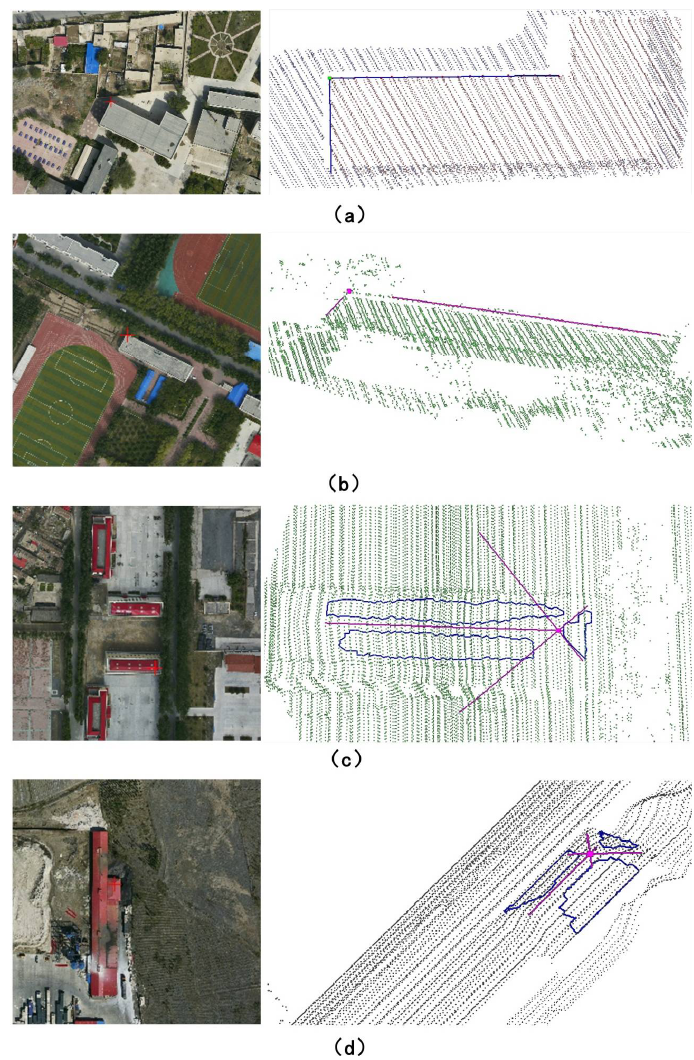
Figure 5. Methods to measure the 3D coordinates of the CPs from LiDAR data: the right is the 3D points measured from the LiDAR data, and the left is the corresponding image points; ( a , b ) are measured by using the intersection of two artificial line segments; ( c , d ) are measured by using the intersection of three different artificial planes.